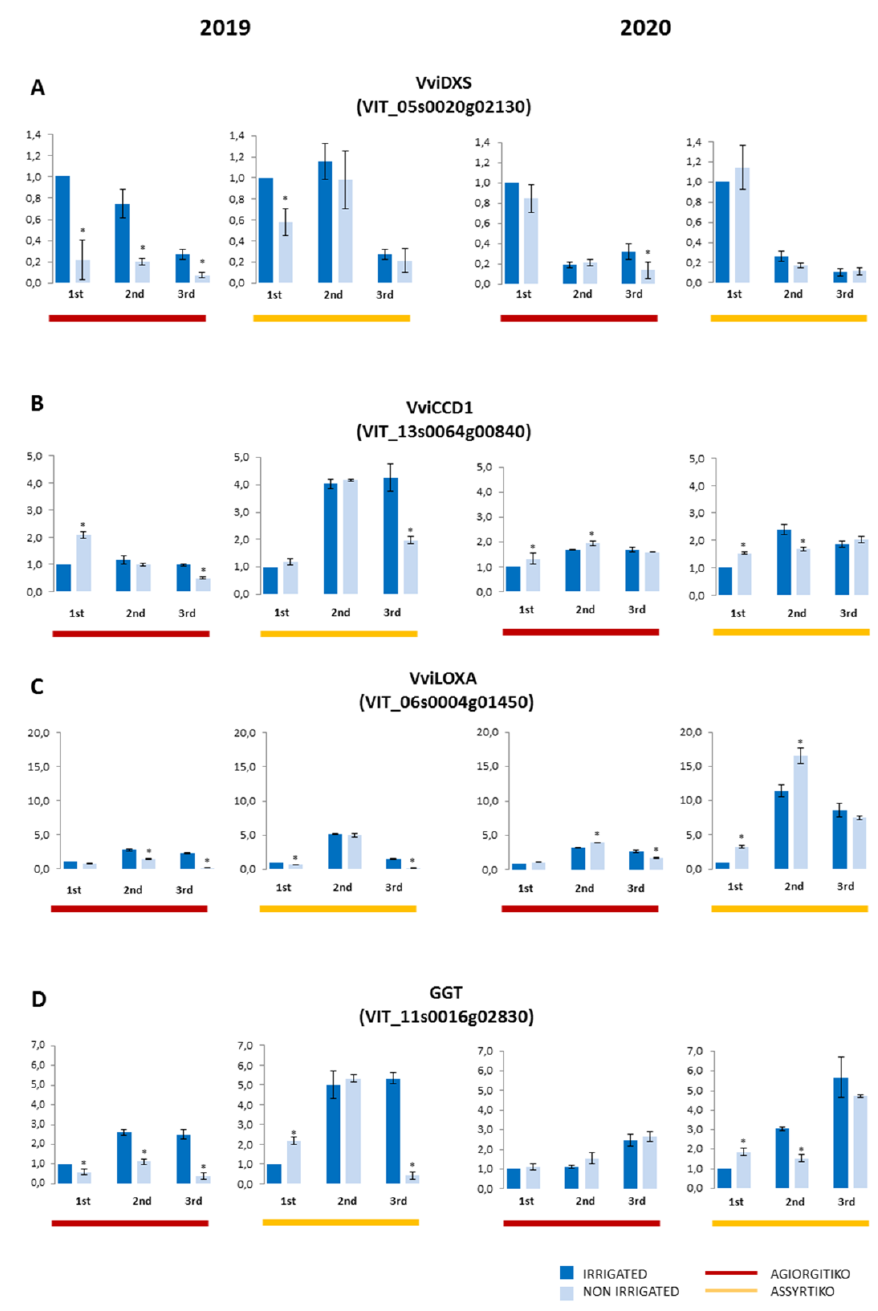
Figure 6. Expression level of genes involved in the biosynthesis of various aroma compounds (VviDXS ( A ), VviCCD1 ( B ), VviLOXA ( C ) and VviGGT ( D ) in Agiorgitiko (red bars) and Asyrtiko (yellow bars) during the two seasons of the experiment (2019 and 2020). The expression levels of irrigated plants are shown in dark blue and those under water deficit are shown in light blue. Vertical bars represent the standard deviation and asterisks indicate the statistically significant differences (Student’s t -test, * p -Value < 0.05) between irrigated and non-irrigated plants of the same sampling period. The three samplings (green berry, 1st; veraison, 2nd and harvest, 3rd) are indicated with numbers under each pair of